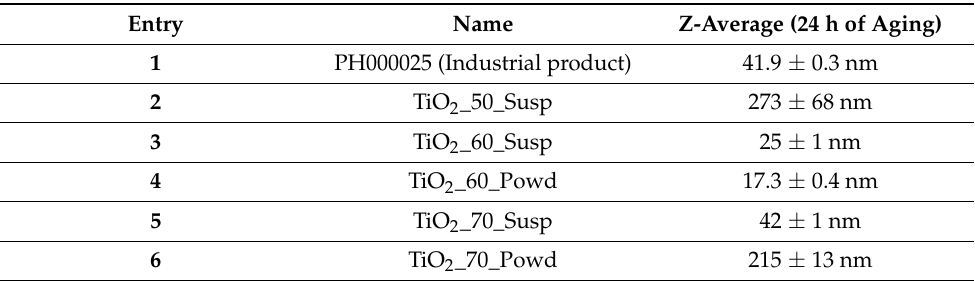
Table 2. DLS measurements on the 5 batches described in this paper after 24 h aging. Errors reported in the table are expressed as standard deviation.